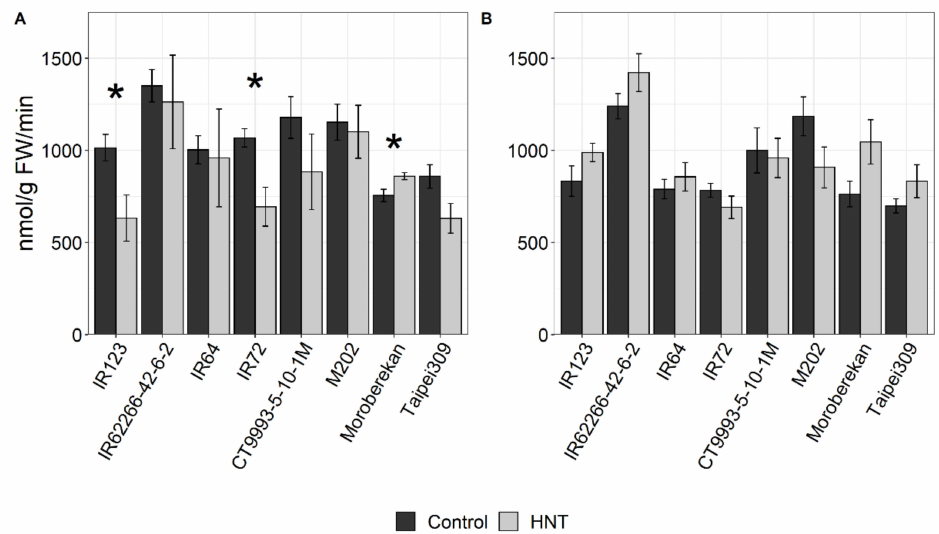
Figure 8. Activity of the enzyme alanine aminotransferase (AlaAT) in panicles of the indicated rice cultivars under control and HNT conditions for the WS ( A ) and DS ( B ). Values are averages of three replicates per cultivar and condition, with four exceptions with two replicates. The level of significance is indicated by asterisks (* p < 0.05; ** p < 0.01; *** p < 0.001). Cultivars were sorted alphabetically within the respective O. sativa subspecies indica (1–4) and japonica